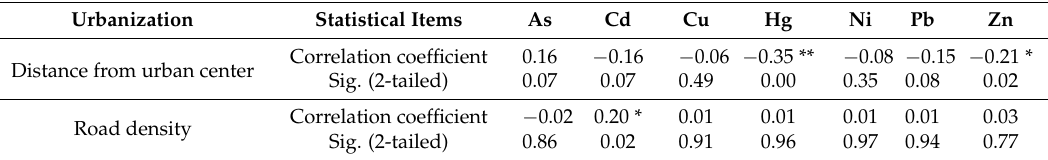
Table 2 Correlations between heavy metals concentions and urbanization indicator. Table 2. Correlations between heavy metals concentions and urbanization indicator.